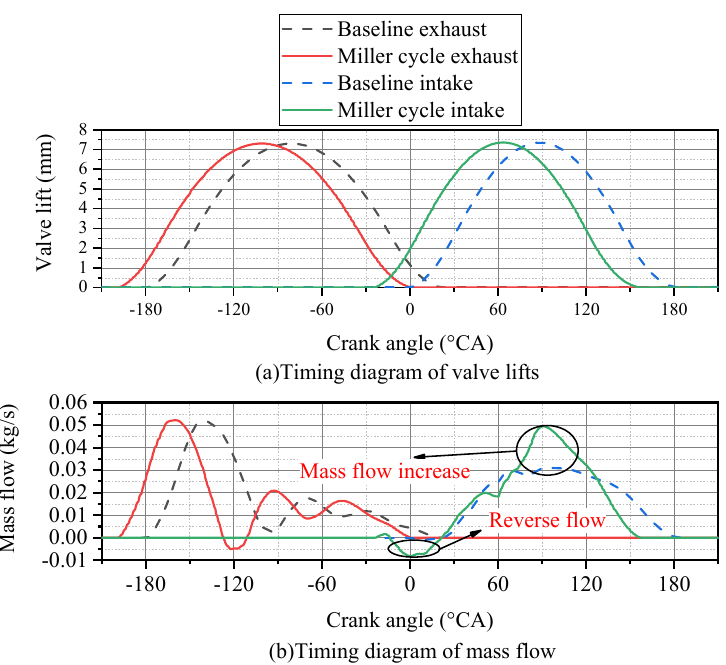
Figure 19. The timing diagram and mass flow rate of the baseline VVT and Miller cycle VVT (point of operation: n = 3000 rpm, BMEP = 10 bar, CA50 = 8 °CA).